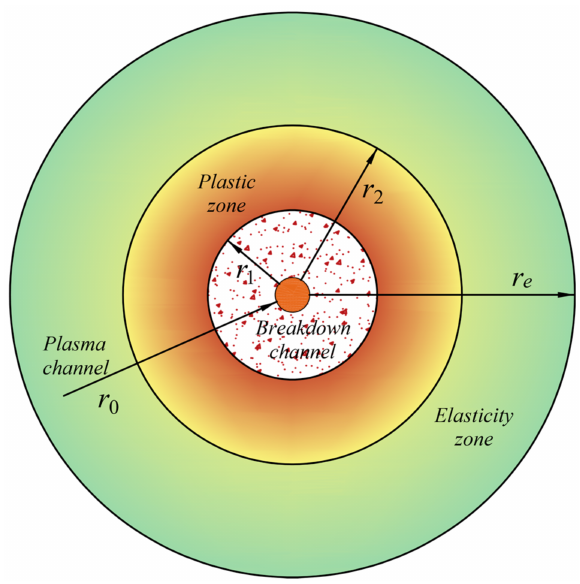
Figure 6. Plasma channel explosion